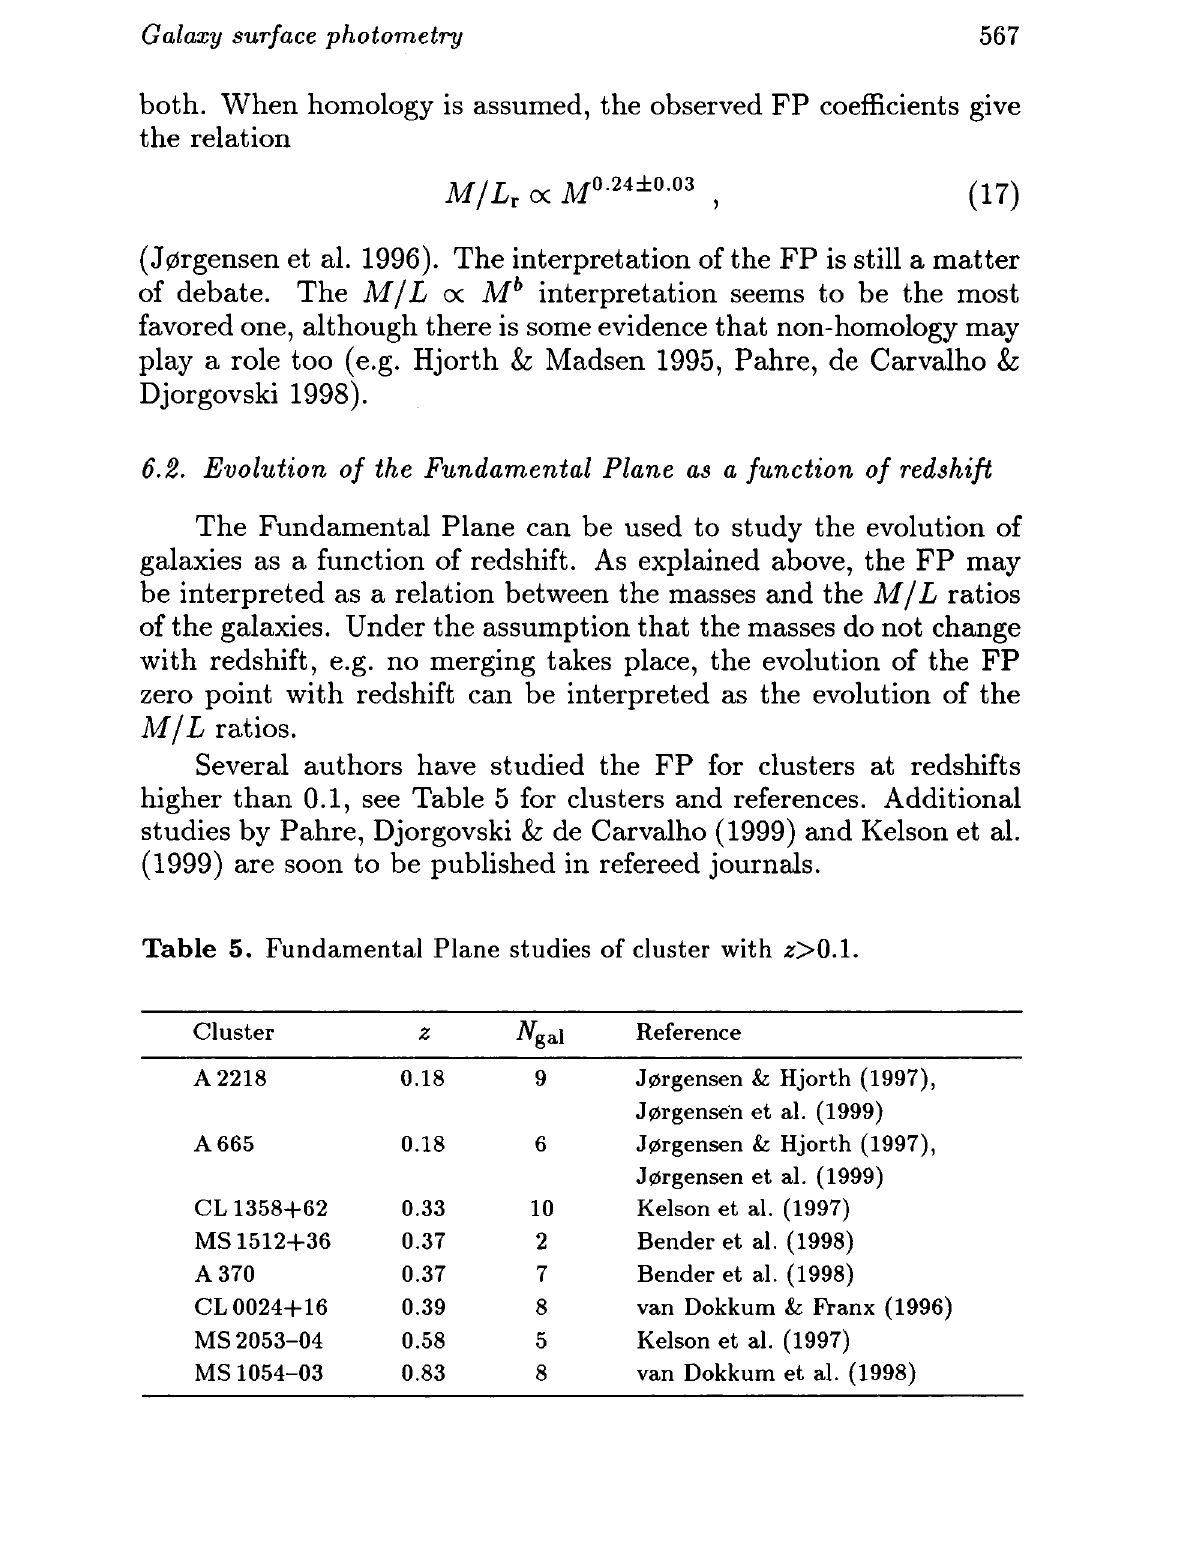
Table 5. Fundamental Plane studies of cluster with z>0.1.